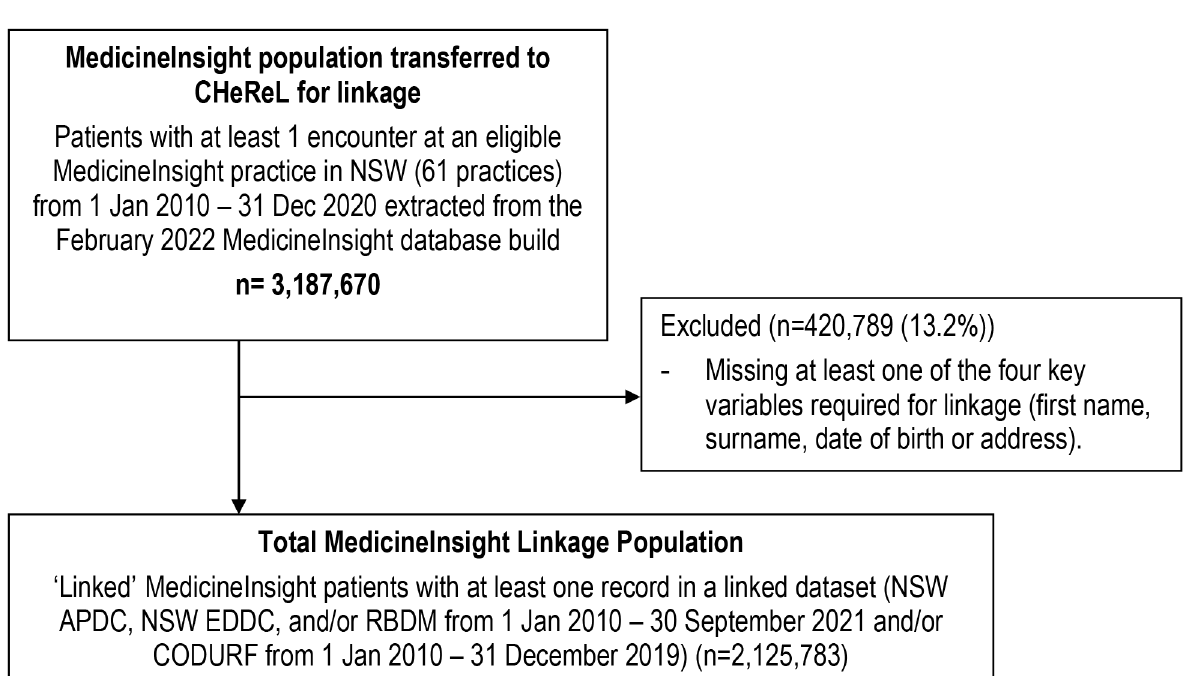
Figure 1: Selection of the MedicineInsight linkage population and the study